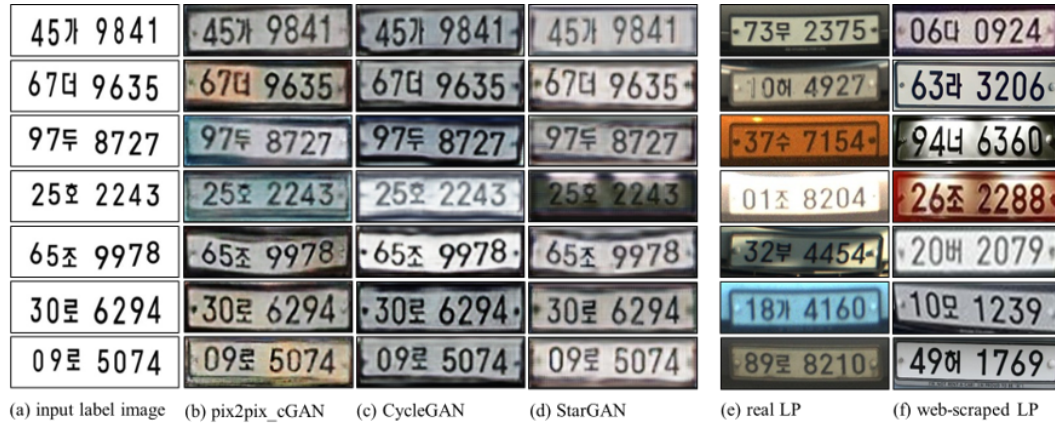
Figure 1. Sample LP images by various LP-GAN generators and real LP